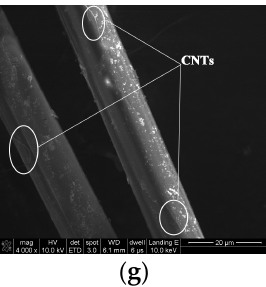
Figure 3. Surface morphologies of Poly(p-phenylene terephthalamide) (PPTA) fibers: ( a ) A-PPTA; ( b ) PPTA-PDA; ( c ) PPTA-1; ( d ) PPTA-2; ( e ) PPTA-3; ( f ) PPTA-4; ( g ) PPTA-5.